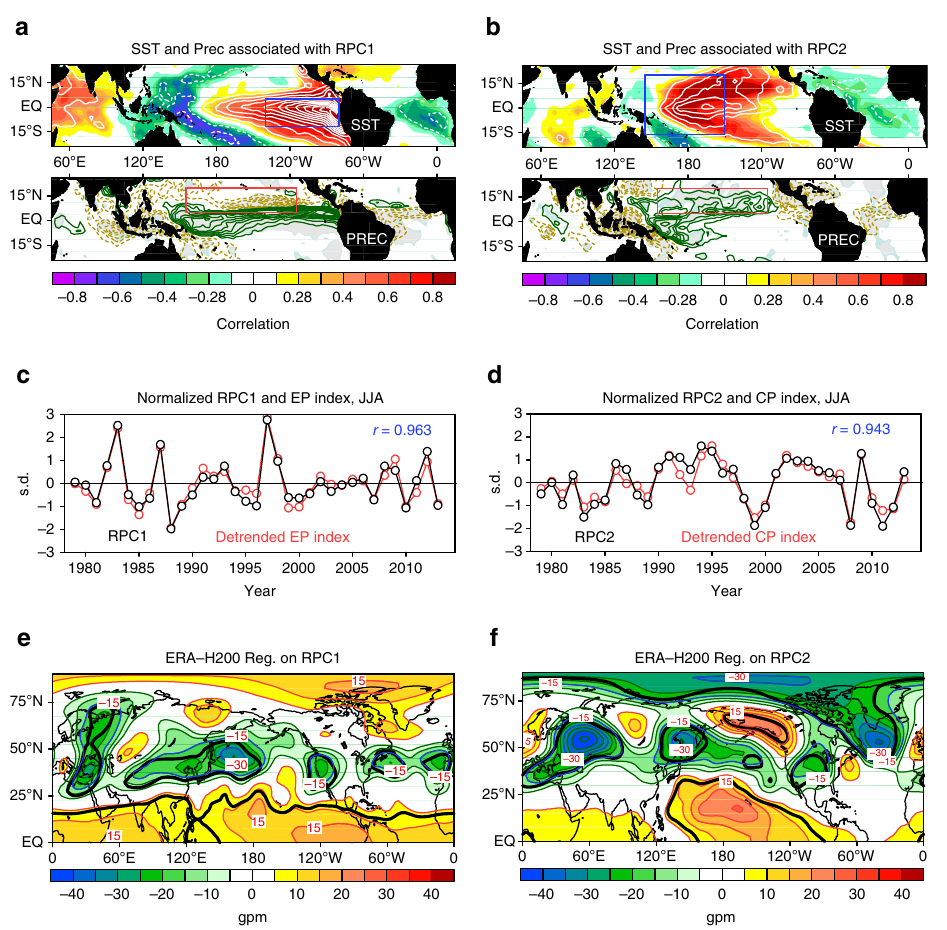
Figure 1 | Statistics of EP El Nin˜o and CP El Nin˜o. Spatial patterns of tropical SST: (( a ) top: colour shadings are used for correlation, and contours are regression with an interval of 0.2 (cid:2) C) marine precipitation (( a ) bottom: regression with an interval of 0.4mm per day) and ERA-H200 (( e ), regression with an interval of 5 gpm) associated with normalized RPC1 ( c , in black). Grey shadings and thick black lines indicate the correlation at the estimated 90% confidence level. Panels b , d , f are the same as panels a , c , e , except for RPC2. In c , d , the time series in red are the detrended and normalized EP and CP indices (see the Methods). Correlation (RPC1, detrended EP index) ¼ 0.963, and correlation (RPC2, detrended CP index) ¼ 0.943. Blue boxes outline the CP region (140 (cid:2) W–80 (cid:2) W, 12 (cid:2) S–5 (cid:2) N) and the EP region (145 (cid:2) E–150 (cid:2) W, 16 (cid:2) S–20 (cid:2) N), respectively. The two red boxes highlight the same region (155 (cid:2) E–115 (cid:2) W, 5 (cid:2) N–20 (cid:2) N) as a reference